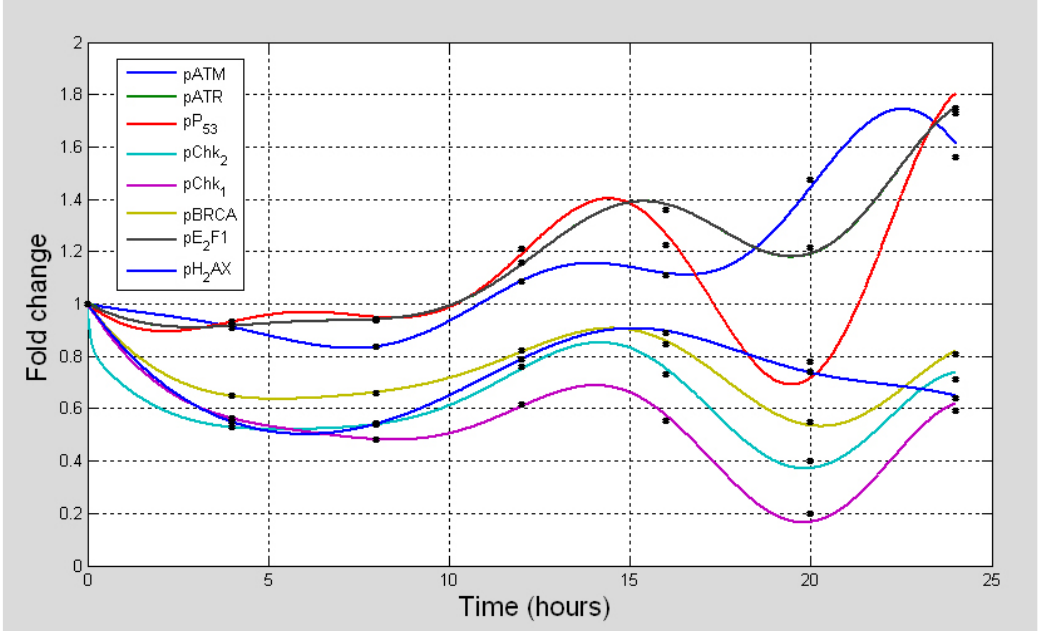
Figure 15. Simulated system dynamics of the DDR pathway that are most consistent with the historical time series measure- ments at (0.1 µ M) dose-intensities of doxorubicin with KU treatment.